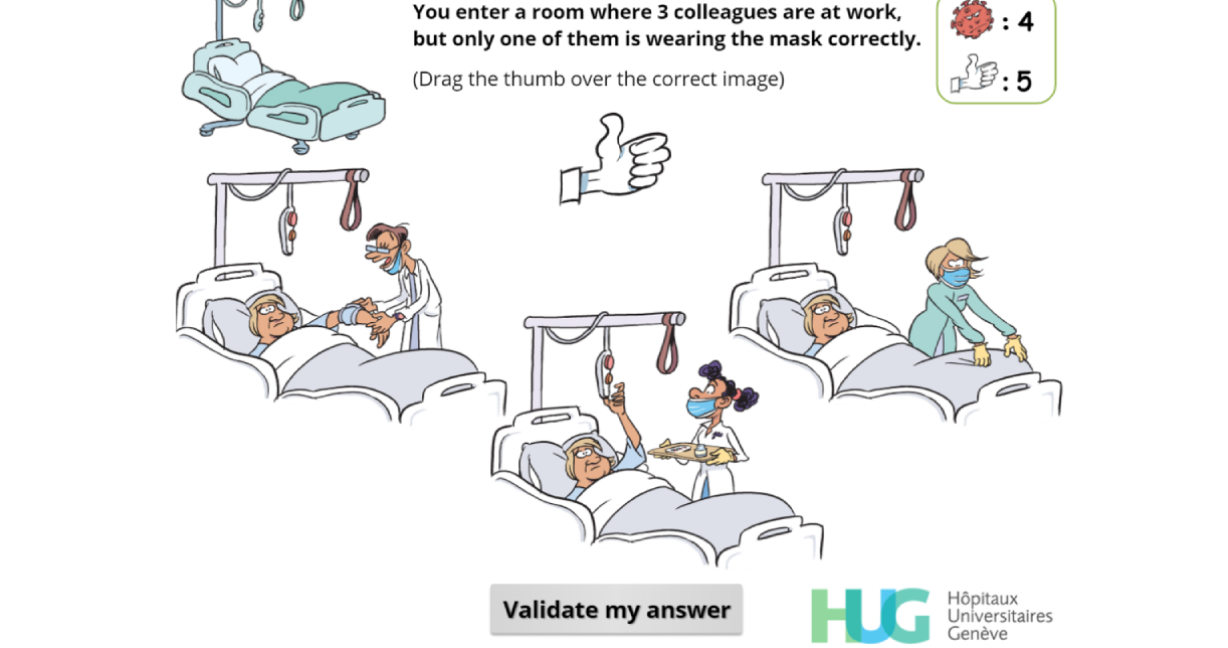
Figure 15. Simple-choice interaction. The player must drag the “thumbs-up” on the image of the only colleague correctly wearing a face mask.